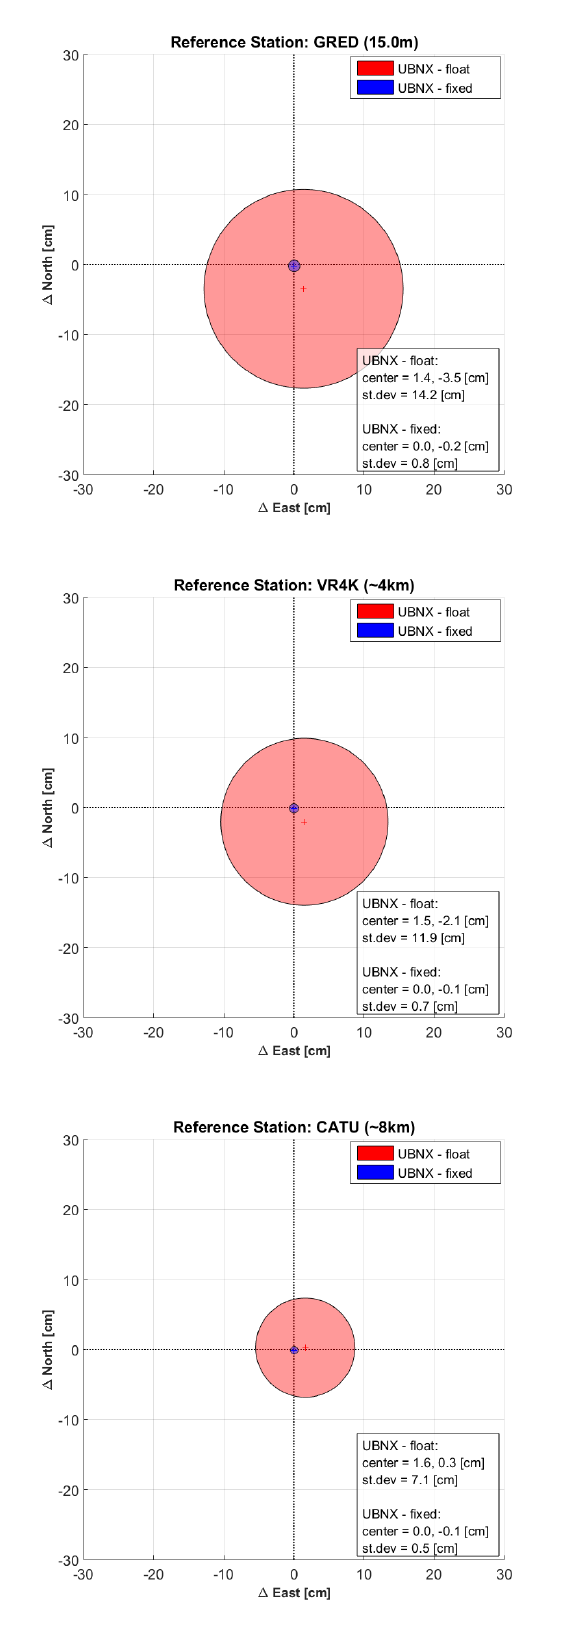
Figure 4. Bias (crosses) and 1-sigma dispersion (circles) of the differences between the 15-min float (red circles) and fixed (blue circles) baselines of UBNX and their respective 1.5-h